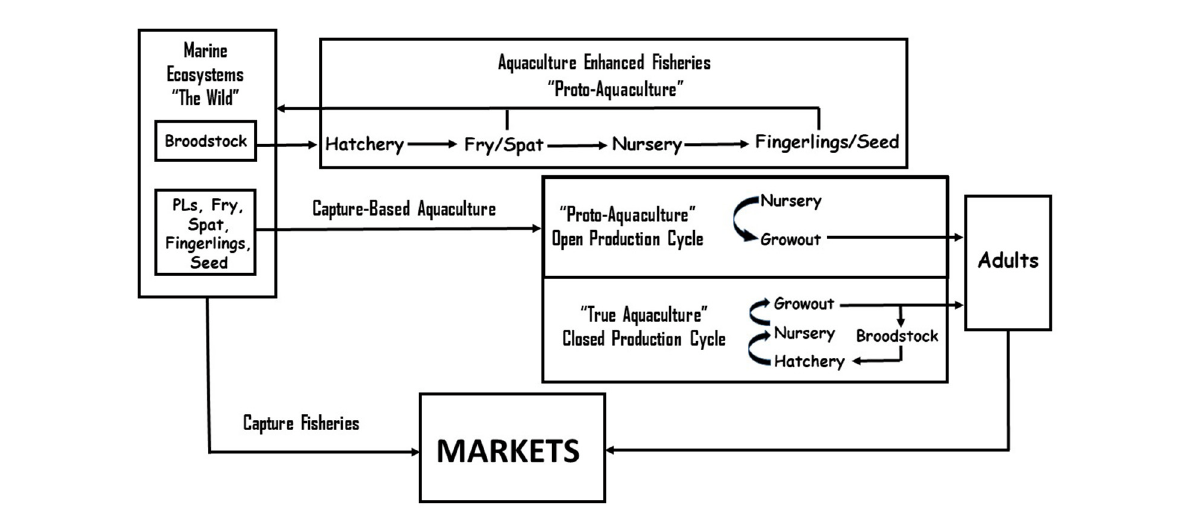
FIGURE1 System connections between marine ecosystems (“the wild”), capture fisheries, capture-based aquaculture, aquaculture-enhanced fisheries, and aquaculture that together enter a common marketplace. “True” full cycle aquaculture is a closed production network where domestication of an aquatic species is underway. Broodstock are selected from species in captivity and selective breeding occurs via genetic improvement with occassional replenishment of broodstock from the wild, but not at the massive scale or dependancy on the wild as practiced in aquaculture-enhanced fisheries. There are scientific, educational, and governance shortcomings ocean/aquatic ecosystems due to poor, duplicative, or incomplete data that have led to artificial policy,management, and institutional barriers that need to be resolved to accelate food production from the waters of the